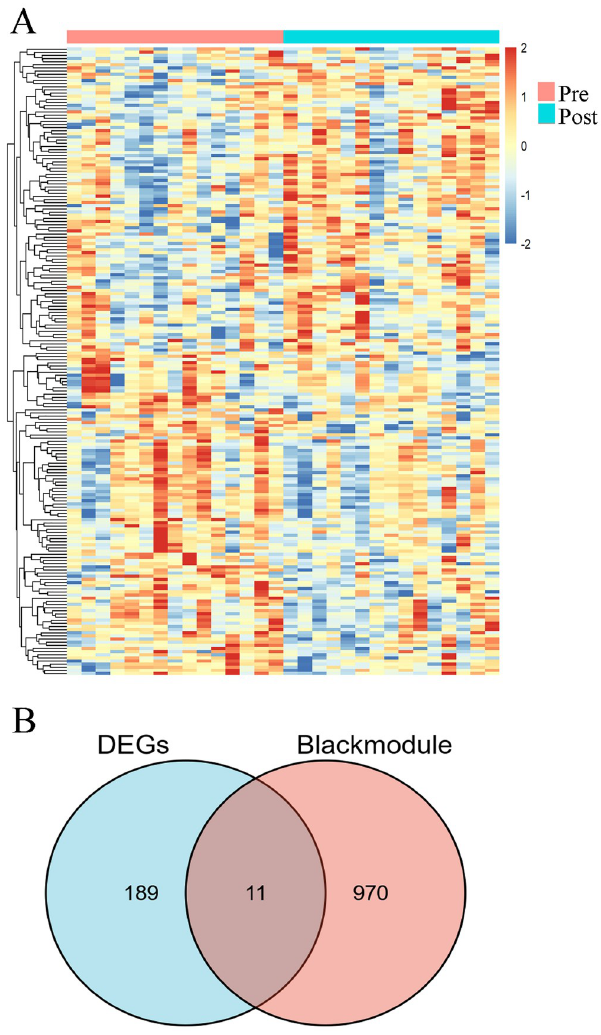
Fig 3. Identification of hub genes by intersection of black module genes and top 200 DEGs. (A) Heat map of the top 200 DEGs. (B) Venn plot of common genes. Part of the hub genes are involved in immune function obviously. Immunoglobulin Lambda Variable 1–40 (IGLV1-40) is a subtype of immunoglobulin light chains, and T cell receptor alpha variable 10 (TRAV10) is a subtype of T cell receptor (TR) alpha chain. V region of them participates in the antigen recognition [27]. CD22 is a receptor predominantly restricted to B cells and its main function is to inhibit BCR signaling [28]. However, direct proofs of closely relationship between the other genes and immunity are limited. For example, the ribosomal protein L10 (RPL10), also known as QM and DXS648, was firstly identified from human tumor cells as a tumor suppressor [29]. It belongs to a highly-conserved compo- nent of the large ribosomal subunit (60S) [30]. Odorant binding protein 2B (OBP2B) belongs to the lipocalin (LCN) family [31]. It played important roles in physiological processes by bind- ing to and transporting small hydrophobic molecules including odorants, retinoids, steroid hormones, and lipids [32]. Meanwhile, there are no related reports whether these 11 hub genes can be used as therapeutic efficacy biomarkers of OSA.